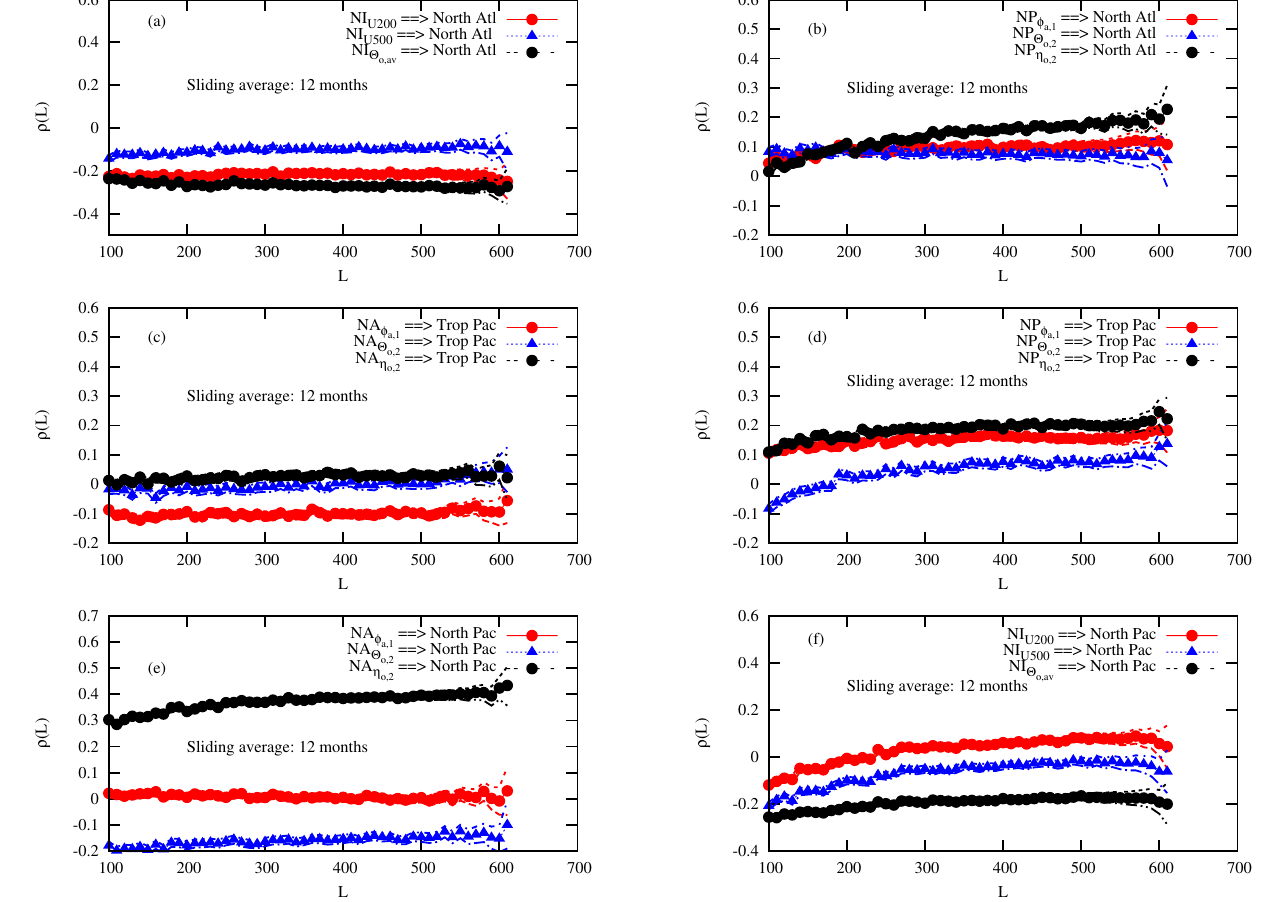
Figure 4. CCM as a function of the length L of the samples, as obtained from the series of Fig. 1 after averaging over a sliding window of 12 months for the ERA-20C and ORA-20C reanalyses. Each line with symbols corresponds to the influence of one variable on a specific coupled ocean–atmosphere basin. The specific variables are denoted in the caption corresponding to each line at each panel.